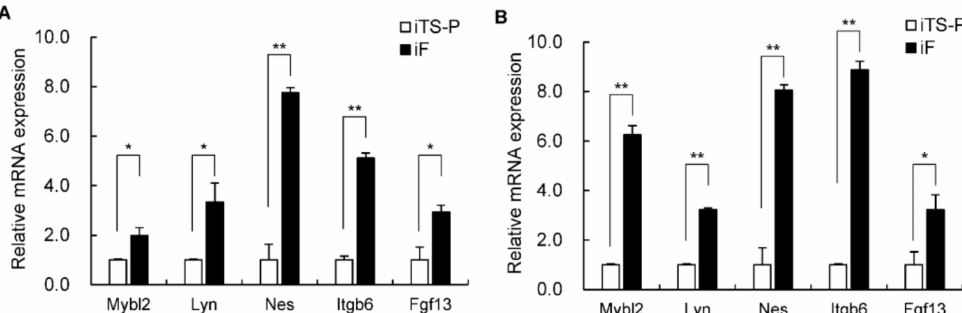
Figure 6. qRT-PCR analysis of the Mybl2, Lyn, Nestin, Itgb6, and Fgf13 genes in iF cells and iTS-P cells at different passages (passage 15) and from different clones (dc-). ( A ) iTS-P cells (passage 15) and iF cells (passage 15) were evaluated for the Mybl2, Lyn, Nestin, Itgb6, and Fgf13 genes using qRT-PCR. ( B ) dc- iTS-P cells and dc-iF cells were evaluated for the Mybl2, Lyn, Nestin, Itgb6, and Fgf13 genes using qRT-PCR. The data are expressed as the gene-to-Gapdh ratio, with this ratio for iTS-P cells arbitrarily set to 1 ( n = 3). The error bars indicate the standard error values. * p < 0.05, ** p <